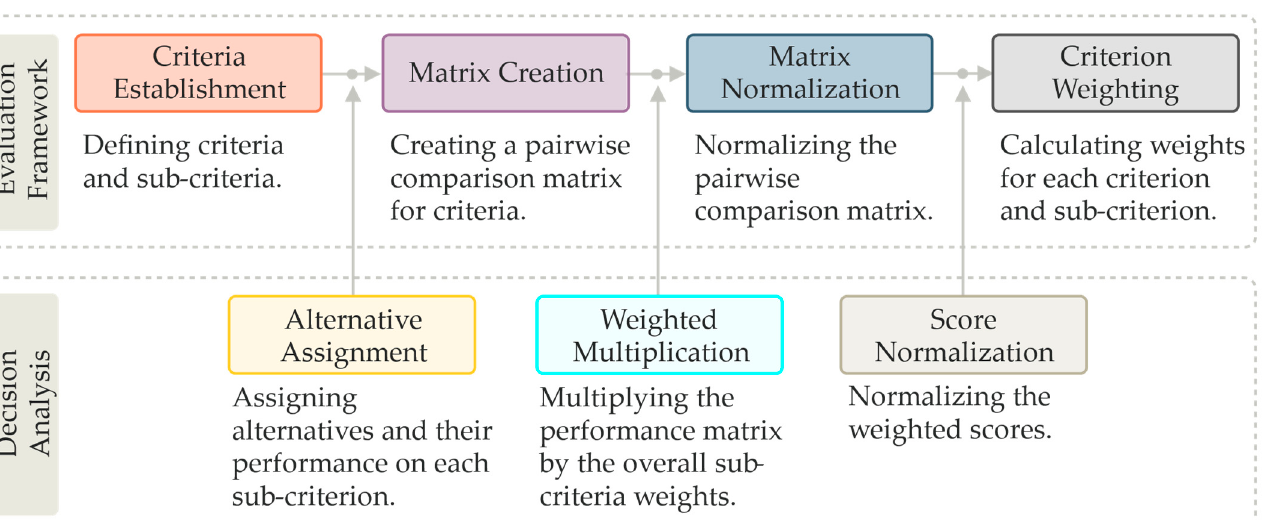
Figure 5. Analysis process fl owchart of policy building block scenarios and AI techniques, o ff ering a consistent and structured approach to weighing nonquantitative factors, prioritizing, and compar- ing the scenario.